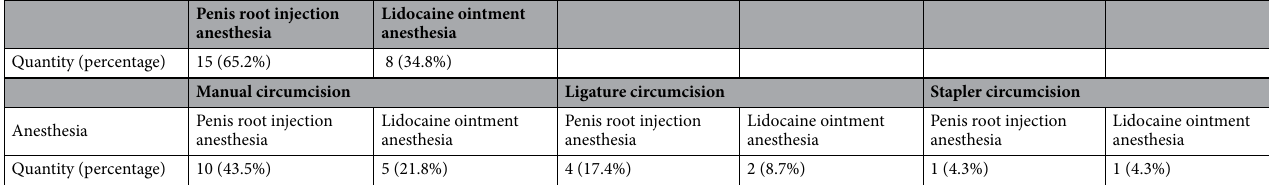
Table 3. Different anesthesia methods have different proportions of secondary epidermoid cysts of the penis after operation. Among the 23 surgical patients, regardless of the total proportion or specific surgical methods, the proportion of secondary epidermoid cysts after penile root injection anesthesia was higher than that of lidocaine cream anesthesia.